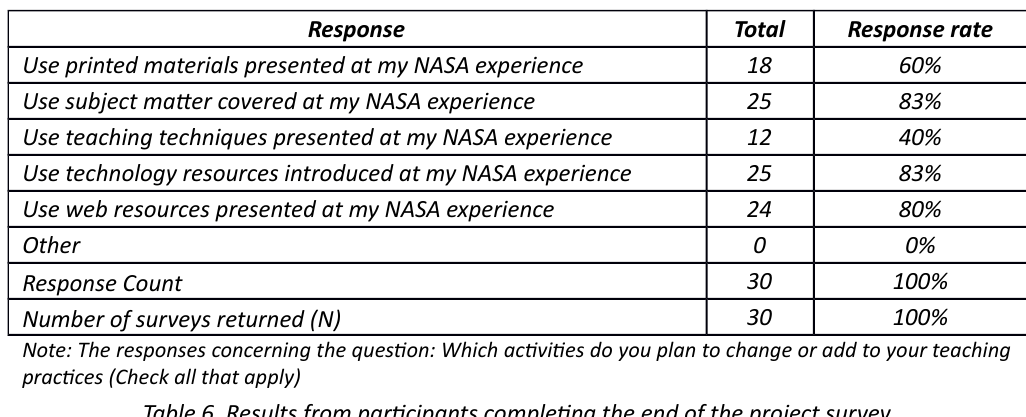
Table 6. Results from partcipants completng the end of the project